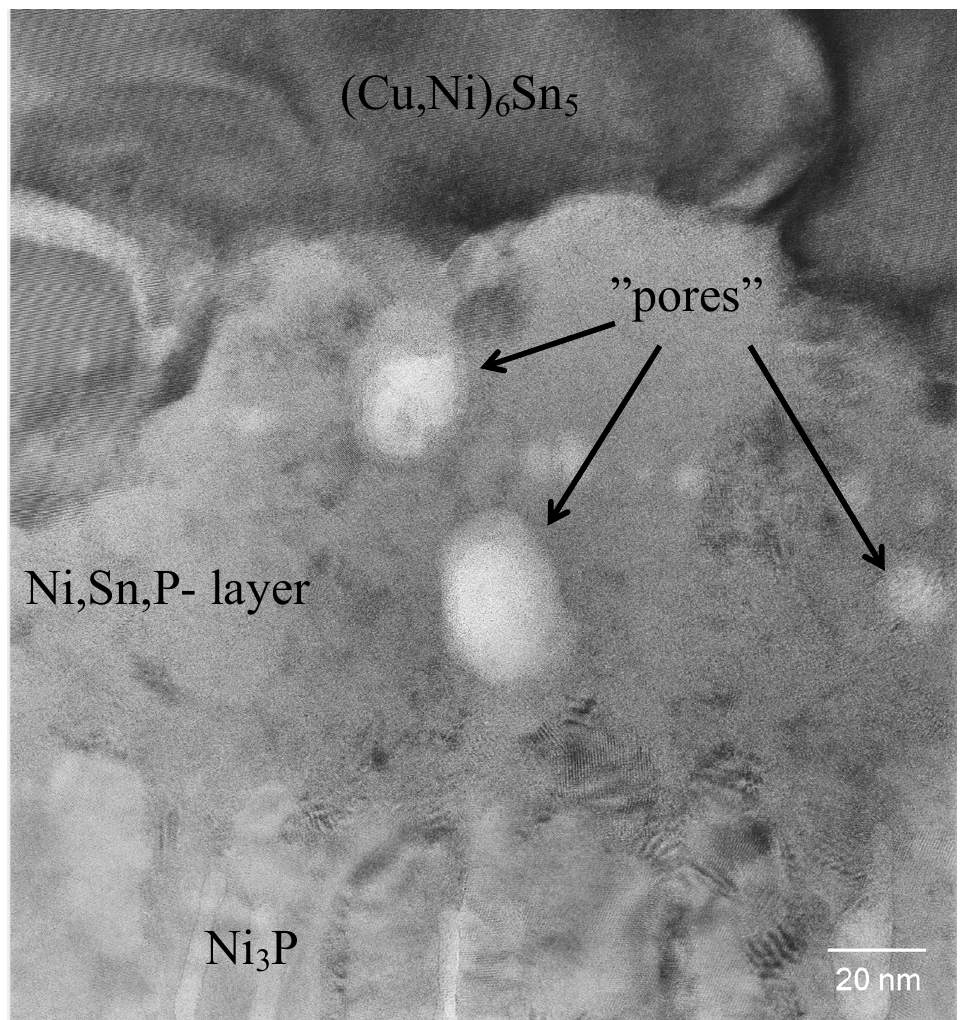
Figure 6. High-resolution phase contrast TEM image of the organic particles in the nanocrystalline Ni-Sn-P